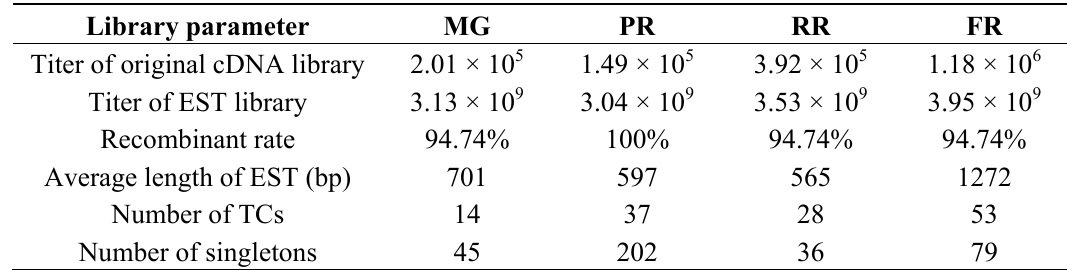
Table 2. cDNA/EST library parameters on the basis of sequencing of 500 recombinant clones from “Biqi” fruit at mature green (MG), pink ripe (PR), red ripe (RR), and full ripe (FR) stages.